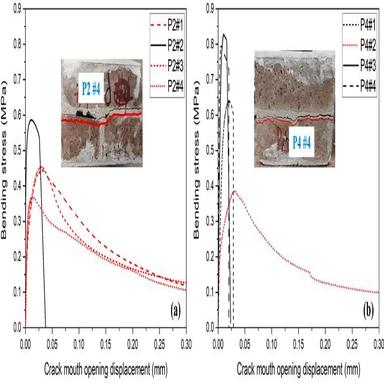
Bending stress at the brick–mortar interfaces with the increase of crack mouth opening displacement for couplets extracted from P2 (a) and P4 (b).